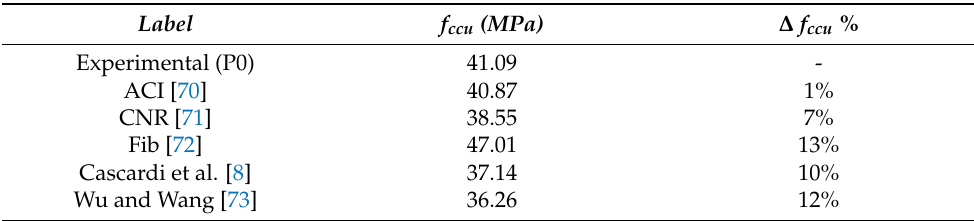
Table 3. Experimental versus theoretical comparison for P0 compressive